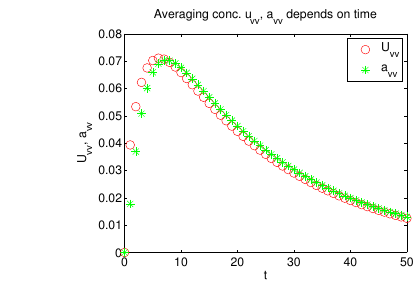
Figure 6. Averaging concentration u v ( r,t f ) depending on r for t f = 50